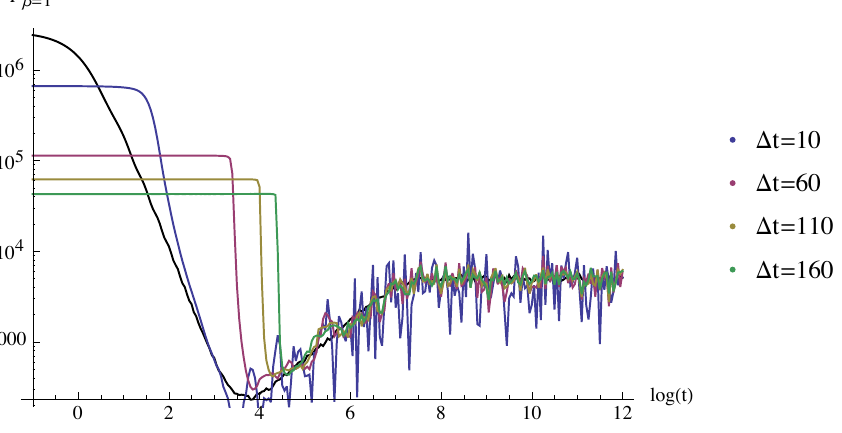
Figure 3 . Log-log plot of the average spectral form factor with (cid:12) = 1 for (cid:12)ve hundred 1024 (cid:2) 1024 matrices drawn from the Gaussian unitary ensemble (GUE) (black), and the sliding window aver- age (3.9) with (cid:12)xed time windows (cid:1) t = 10 ; 60 ; 110 ; 160 (color) for a single instance of a random matrix. Notice that for averaging with a (cid:12)xed time window there is tension between preserving the dip and having a su(cid:14)ciently smooth ramp and plateau.